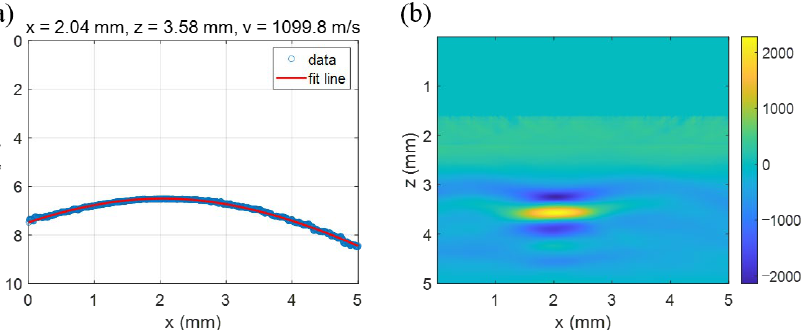
Figure 9. ( a ) The hyperbola curve fitting for extracting the acoustic velocity and ( b ) the T-SAFT image reconstruction made with the extracted velocity. The pencil lead initially placed at around 3.5 mm depth was reconstructed at 3.57 mm.